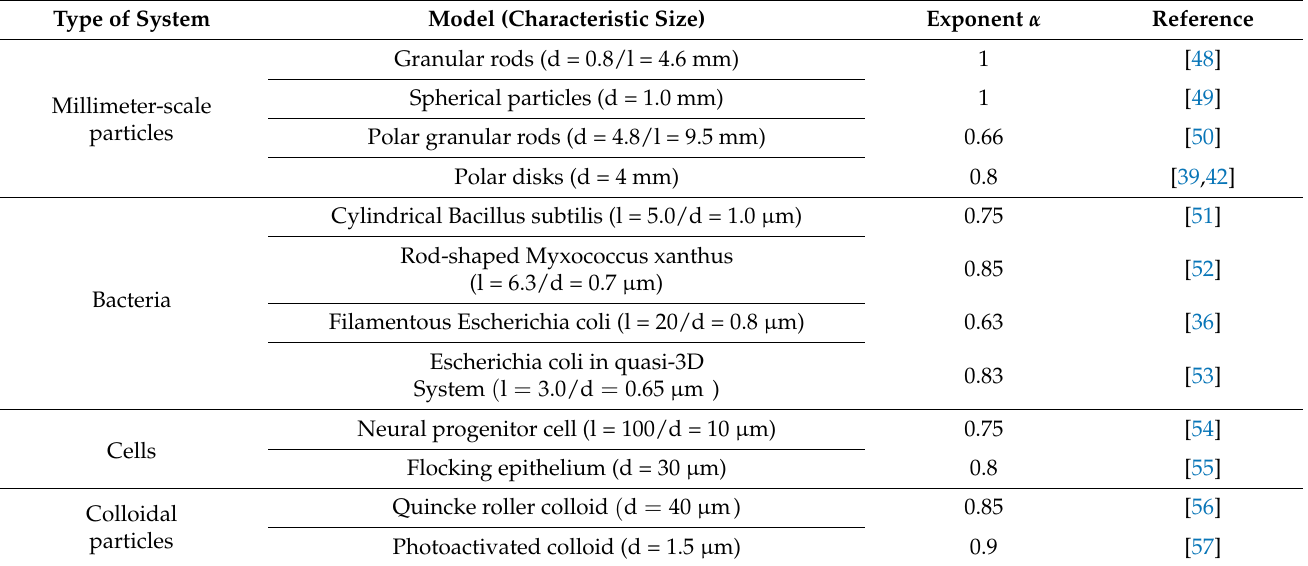
Table 1. Giant number fluctuations (GNFs) phenomena in experiments; d = diameter, l = length. Type of